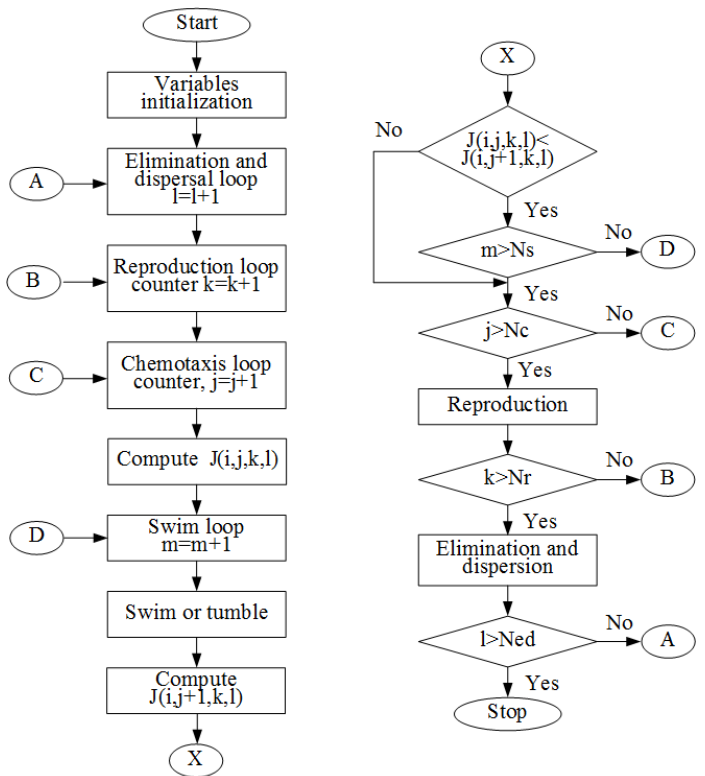
Figure 4. Flowchart of the BFO method.